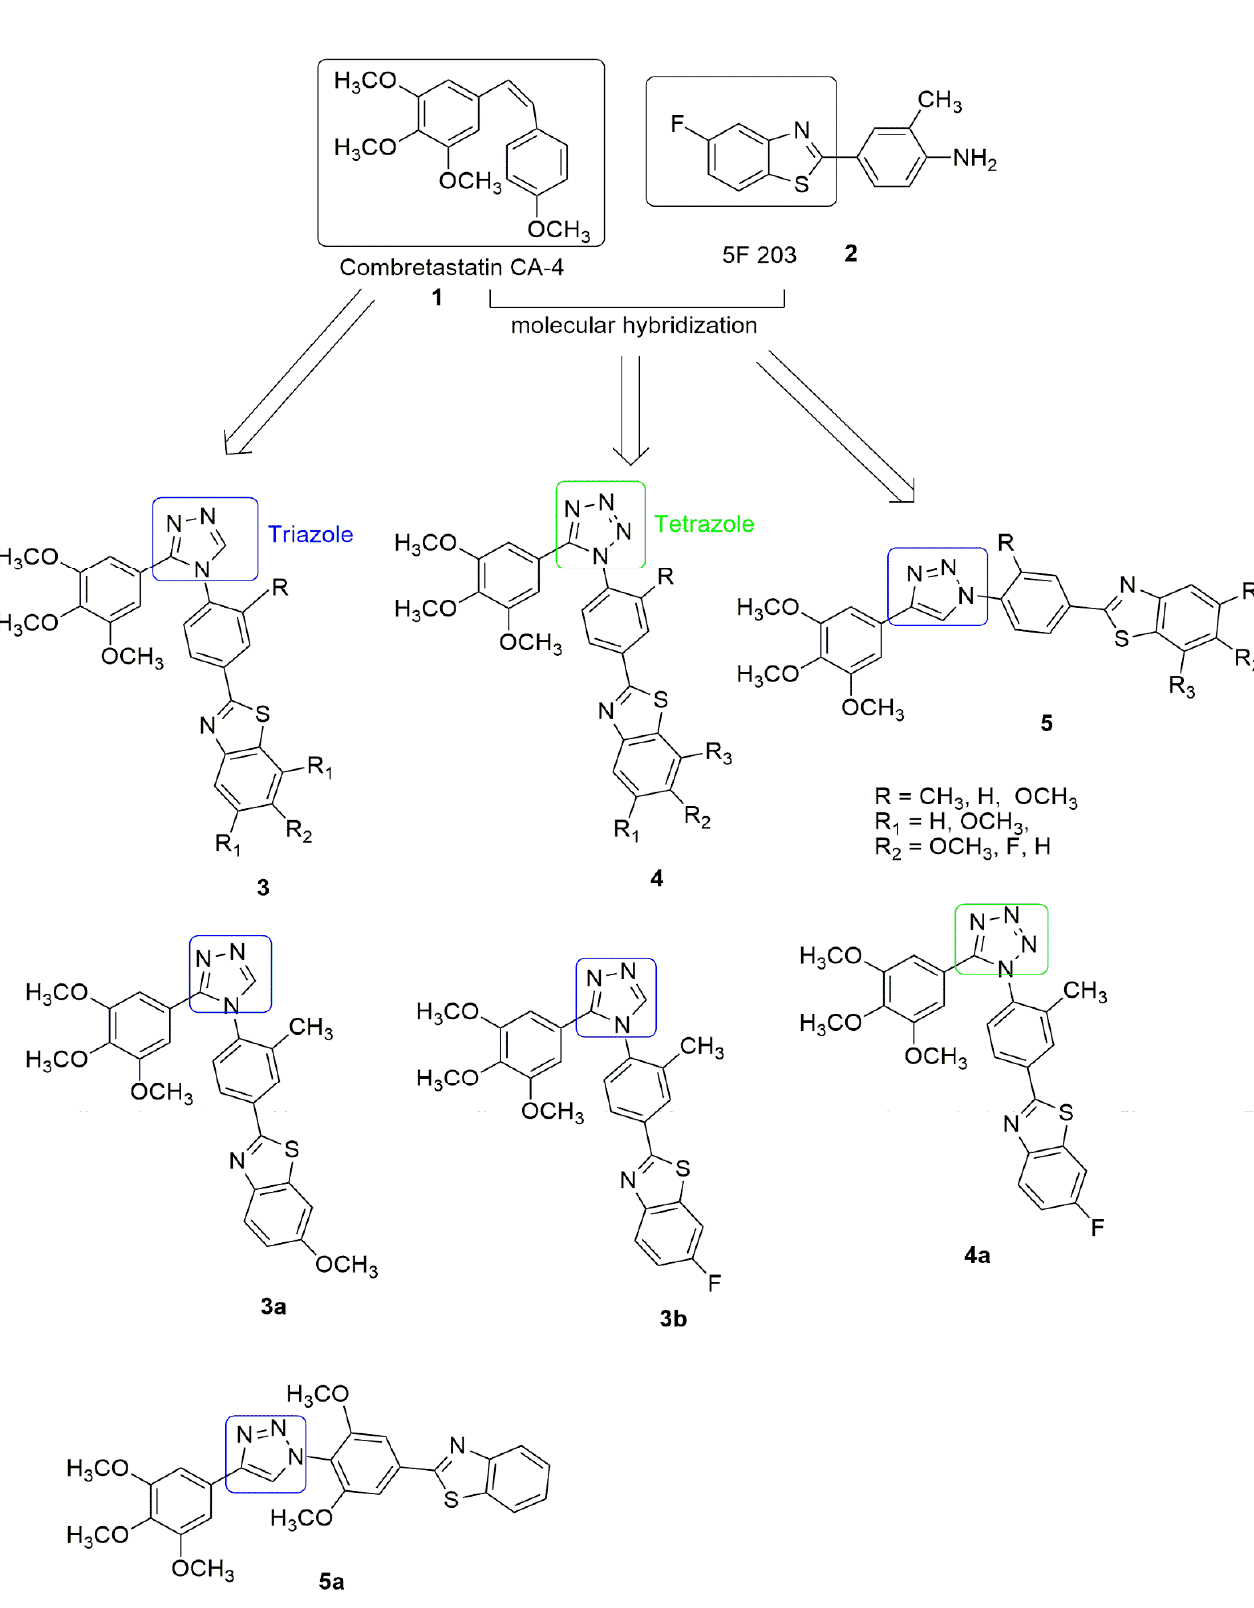
Figure 3. Chemical structures of triazole/tetrazole–benzothiazole hybrids with anti-tubulin activities. Xu et al. [18] synthesized series of 3,6-diaryl-7 H -[1,2,4]triazolo[3,4-b][1,3,4]thiadiazines by replacing the ( Z , E )-butadiene the spacer of vinylogous CA-4 5 with a novel rigid [1,2,4]triazolo[3,4-b][1,3,4]thiadiazine moiety. Subsequently, the antiproliferative